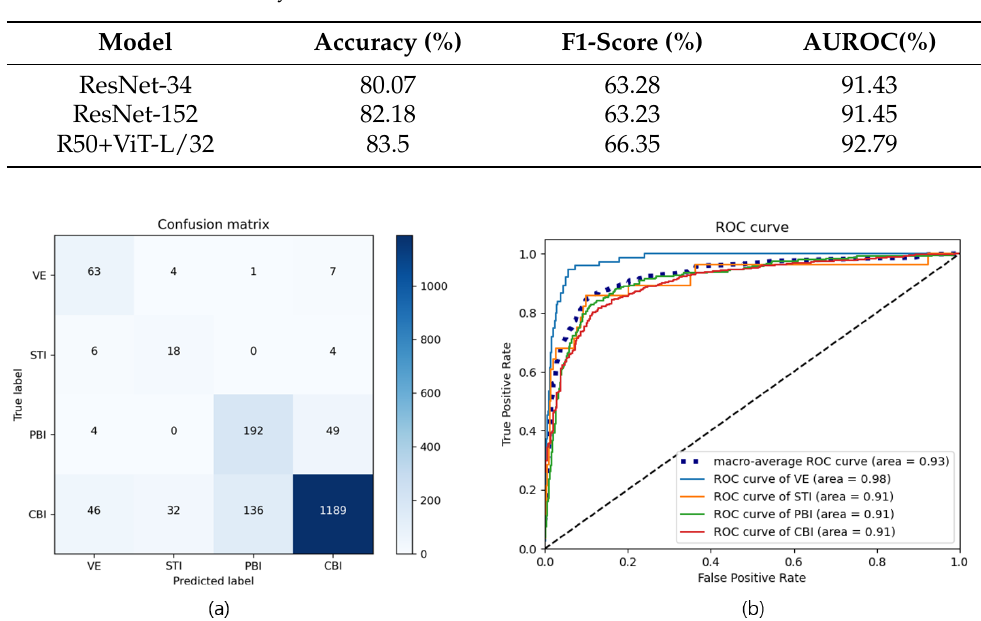
Table 2. Extraction difficulty classification result.